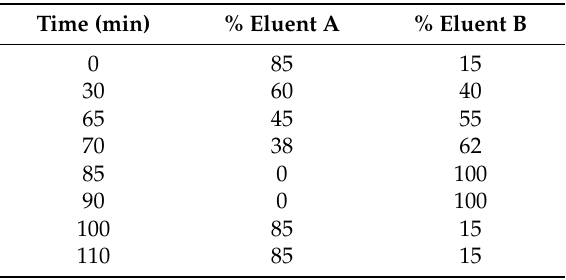
Table 1. RP-HPLC-PDA-ESI-MSn analysis elution